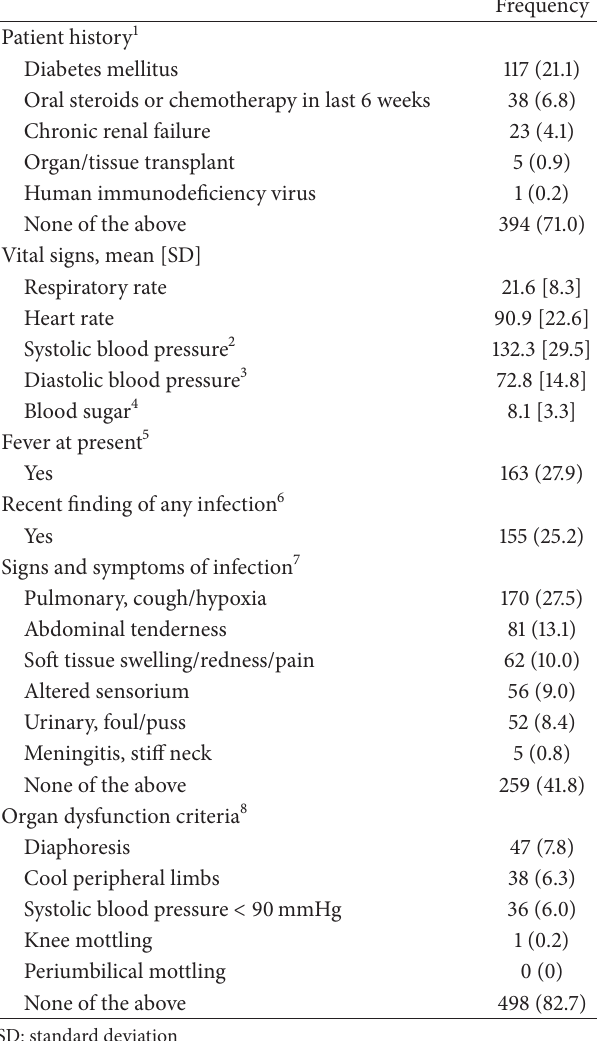
Table 2: Patient characteristics. Table 3: Contingency table comparing paramedic identification of sepsis with emergency physician diagnosis of